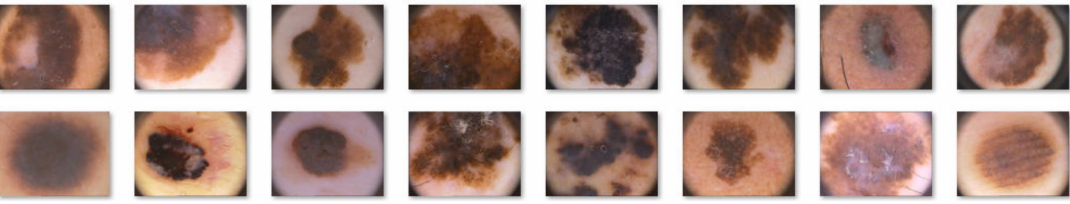
Figure 2. Melanoma images extracted from the PH 2 and ISIC 2019